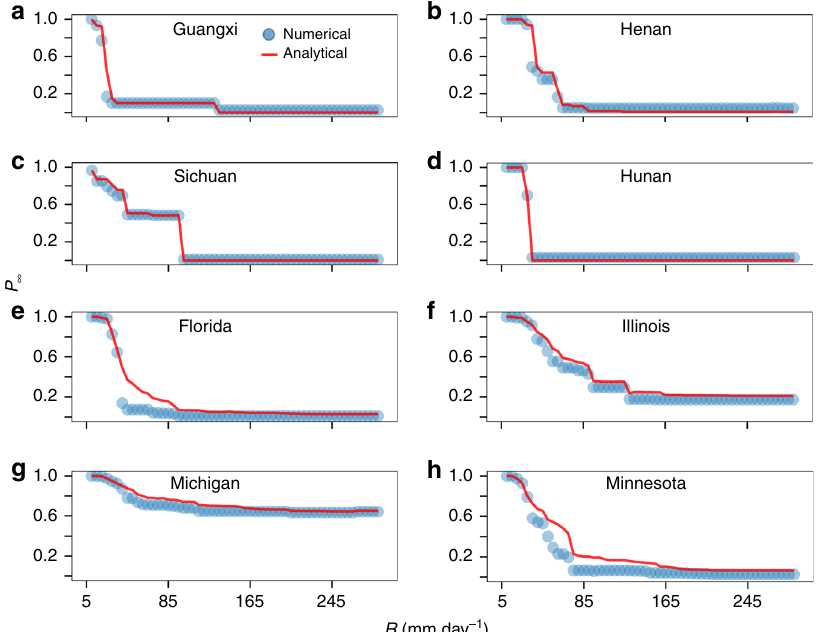
Fig. 5 Comparison of numerical and analytical solutions. a The fraction of nodes in the giant connected component ( P ∞ ) of a road subnetwork in Guangxi as a function of surface runoff ( R ). Blue points represent the numerical results while the red line represents the analytical results. b – h Giant connected component for road subnetworks as a function of surface